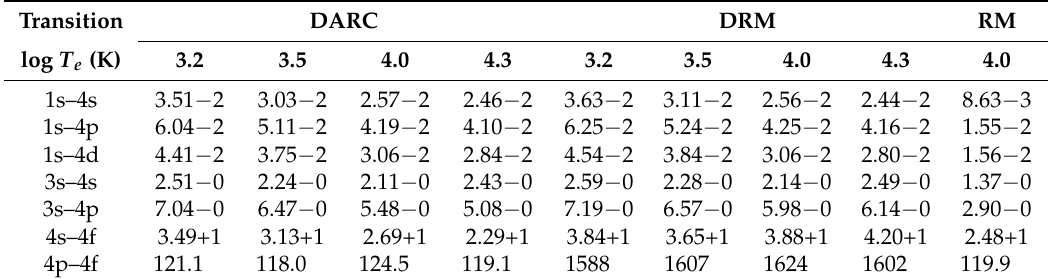
Table 6. Comparison of effective collision strengths ( Υ ) for some transitions of He II. ( a ± b ≡ a × 10 ± b ).